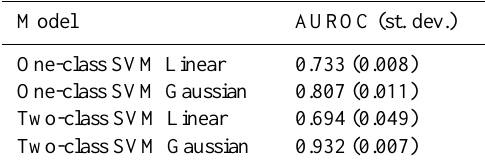
Table 1. Comparison of di ff erent models. AUROC and correspond- ing standard deviations are evaluated on 20 random splits.